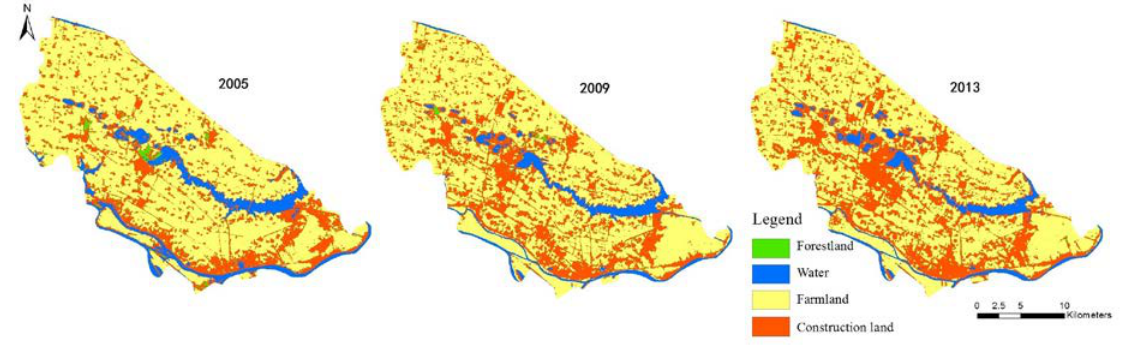
Figure 2. Landscape classification maps in Panji District (2005, 2009, and